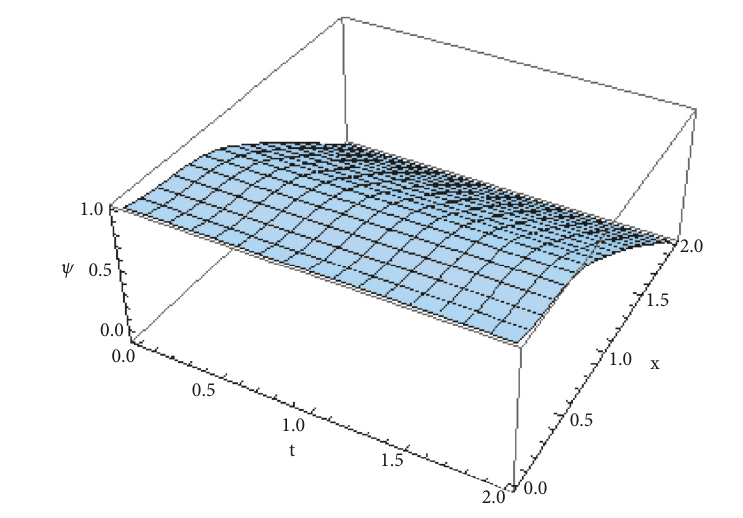
Figure 2: Real solution of the one-dimensional wave function obtained by NDsolve.